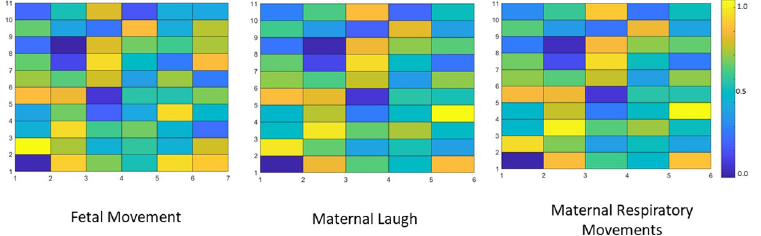
Fig 13. The resulting base matrices (W matrices) for three classes. The resulting base matrix(W matrix) of three different classes can be observed in this figure. The output of the NNMF algorithm are two matrices, W matrix and H matrix. In order to visualize the matrix the amplitude of each element of the matrix is converted in to a corresponding colour. As a result of this a figure in a grid format was obtained.